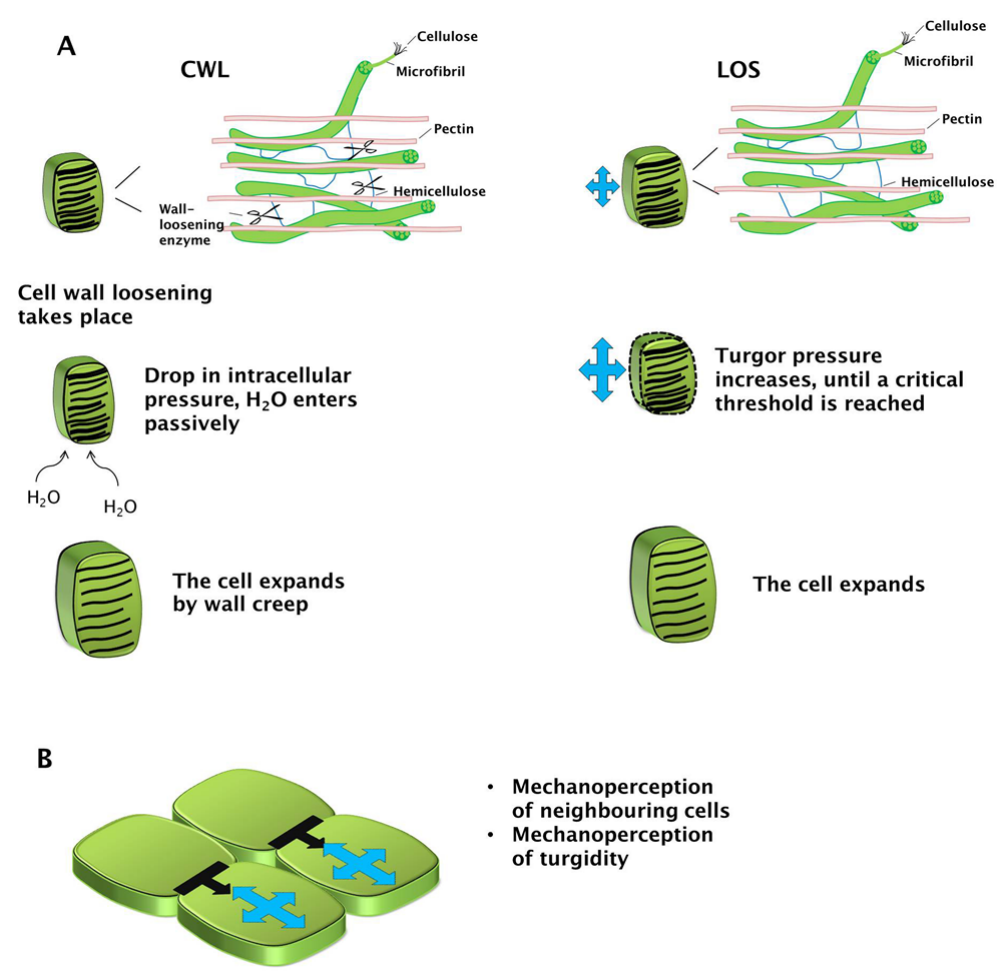
Figure 2. Models of plant cell expansion and mechanosensory signals. ( A ) Cartoons depicting the steps marking growth according to the CWL and LOS models; the dotted line represents the critical yield threshold of the wall; ( B ) Mechanosensory signals coming from neighbouring cells (black arrows) and from the turgidity of the expanding cells (blue